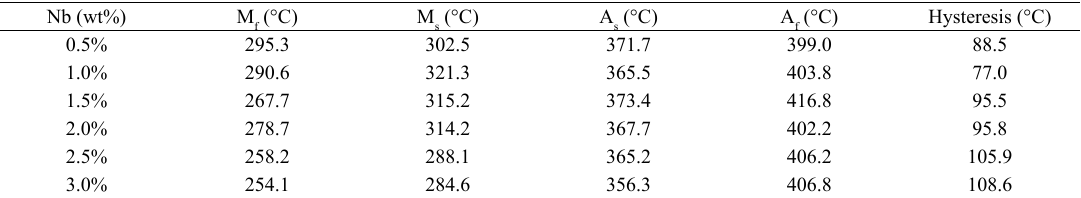
Table 2. Martensitic transformation temperatures and thermal hysteresis of the Cu-Al-Nb HTSMA samples after post cycling with later re-quenching. Nb (wt%)